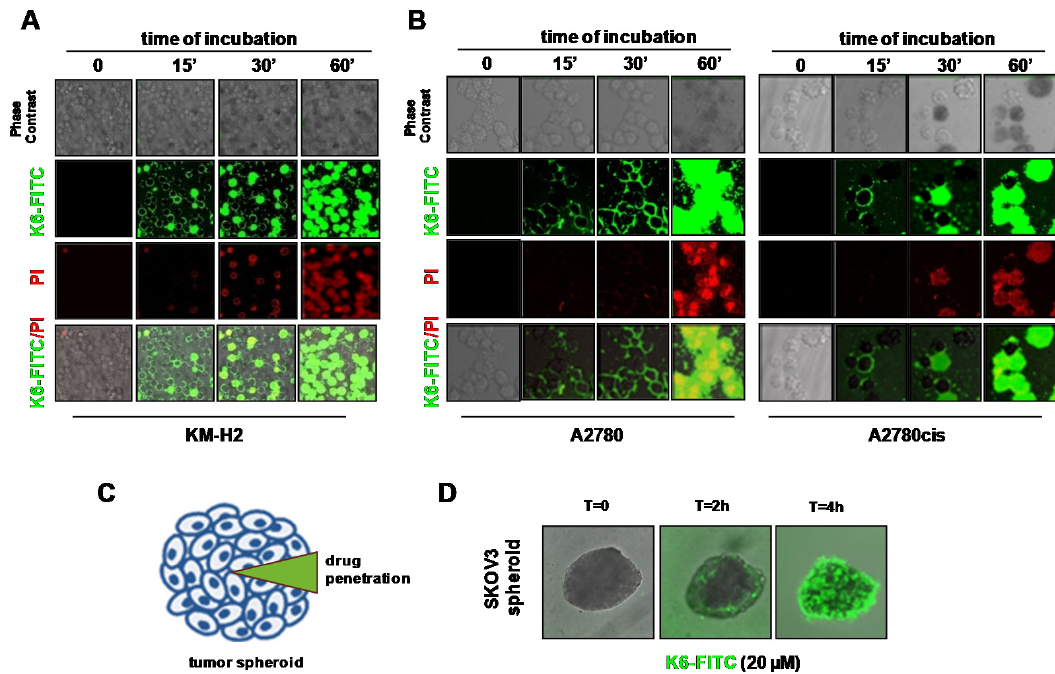
Figure 4. K6-FITC uptake by HL OvCa cells and OvCa spheroids. Representative confocal images showing ( A ) KM-H2 ( B ) A2780 (left panels) and A2780cis cells (right panels) double stained with K6-FITC (30 µM) (green) and propidium iodide (PI) (red) at various time points. ( C ) Illustration of drug penetration kinetic into spheroid. ( D ) Representative photomicrographs of a SKOV3 spheroid treated with K6-FITC (20 µM) and analyzed for K6-FITC uptake by confocal microscopy time-lapse.